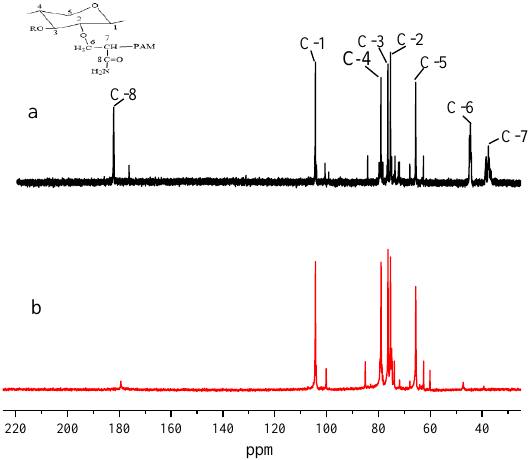
Figure 4. 13 C-NMR Spectra of xylan-g-PAM ( a ) and xylan ( b ).